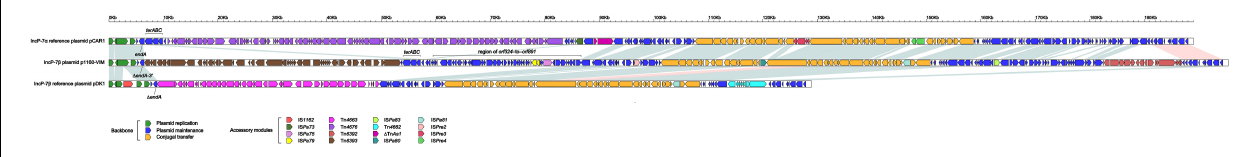
FIGURE 2 | Linear comparison of p1160-VIM with related plasmids. A linear comparison is carried out for complete DNA sequences of pCAR1 (accession number AB088420), p1160-VIM (this study), and pDK1 (accession number AB434906). Genes are denoted by arrows. Genes, mobile elements and other features are colored based on function classification. Blue shading denotes regions of homology ( > 95% nucleotide identity), and pink shading denotes regions of homology (nucleotide identity between 90 and 95%). TABLE 2 | Drug resistance genes in mobile elements sequenced this